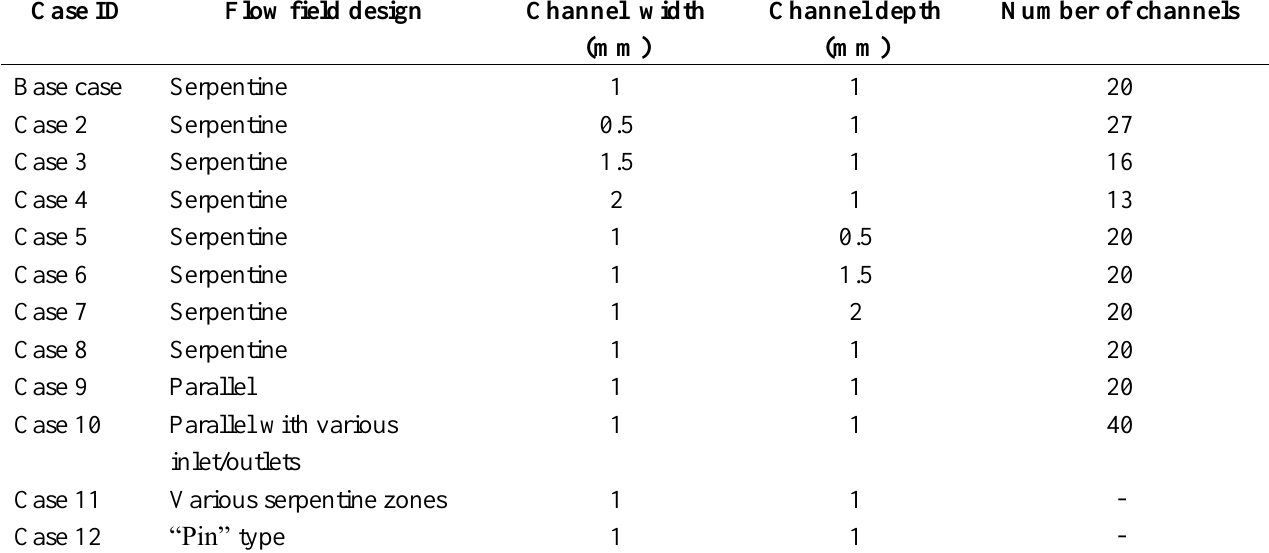
Table 2. Description of the configurations studied in the sensitivity